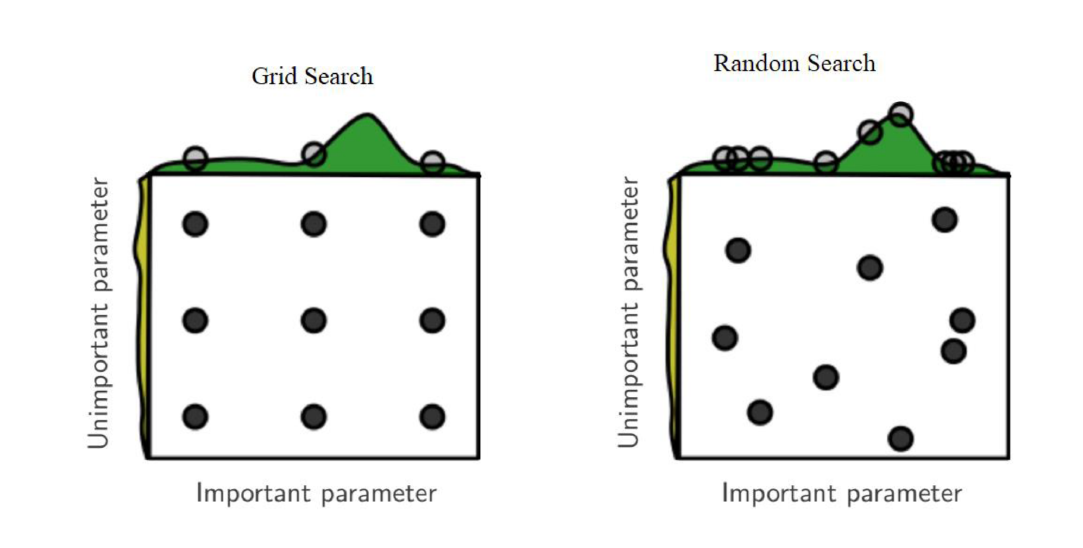
Fig. 2. Comparison between GS and RS